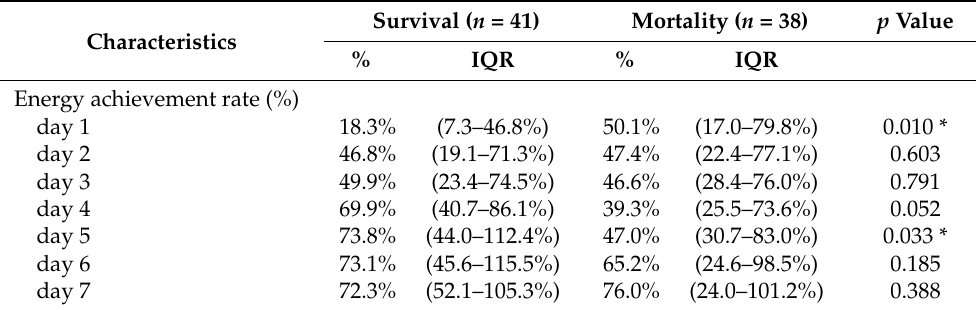
Table A1. Comparison of EAR between survival and non-survival groups during the first week of ICU